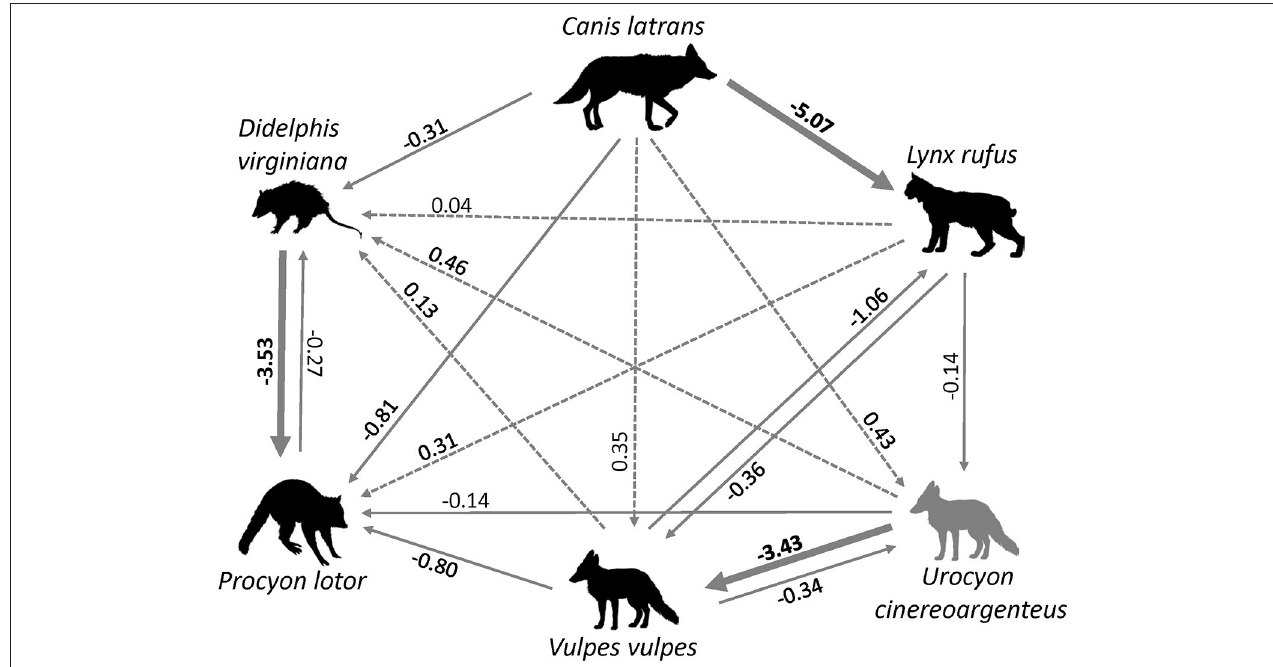
FIGURE 3 | Interspecific relations between six carnivore species in Ohio inferred from occupancy models, with the direction of the arrow showing the direction of the effect. Solid arrows indicate negative relations, dotted arrows indicate positive relations. Bold lines and coefficients indicate statistically significance. (source of carnivore drawings: